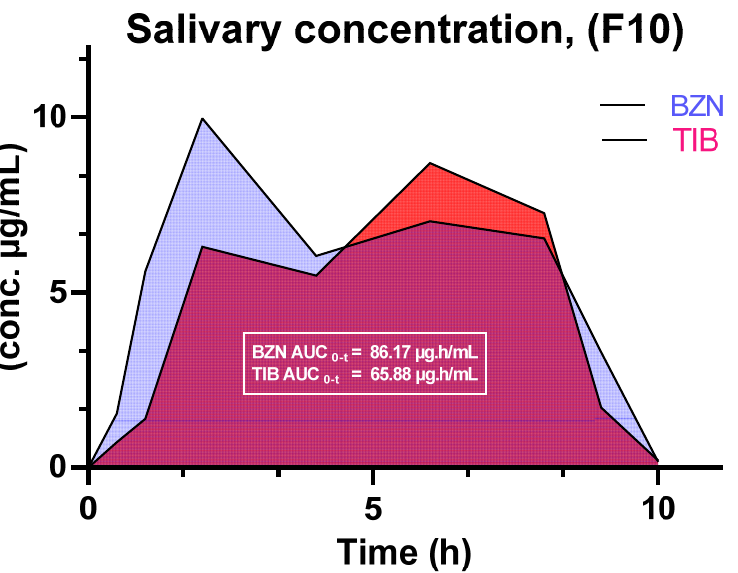
Figure 13. Area under the curve (AUC) for BZN and TIB as a function of time. Table 5. Pharmacokinetic estimation of BZN and TIB in saliva of healthy volunteers.